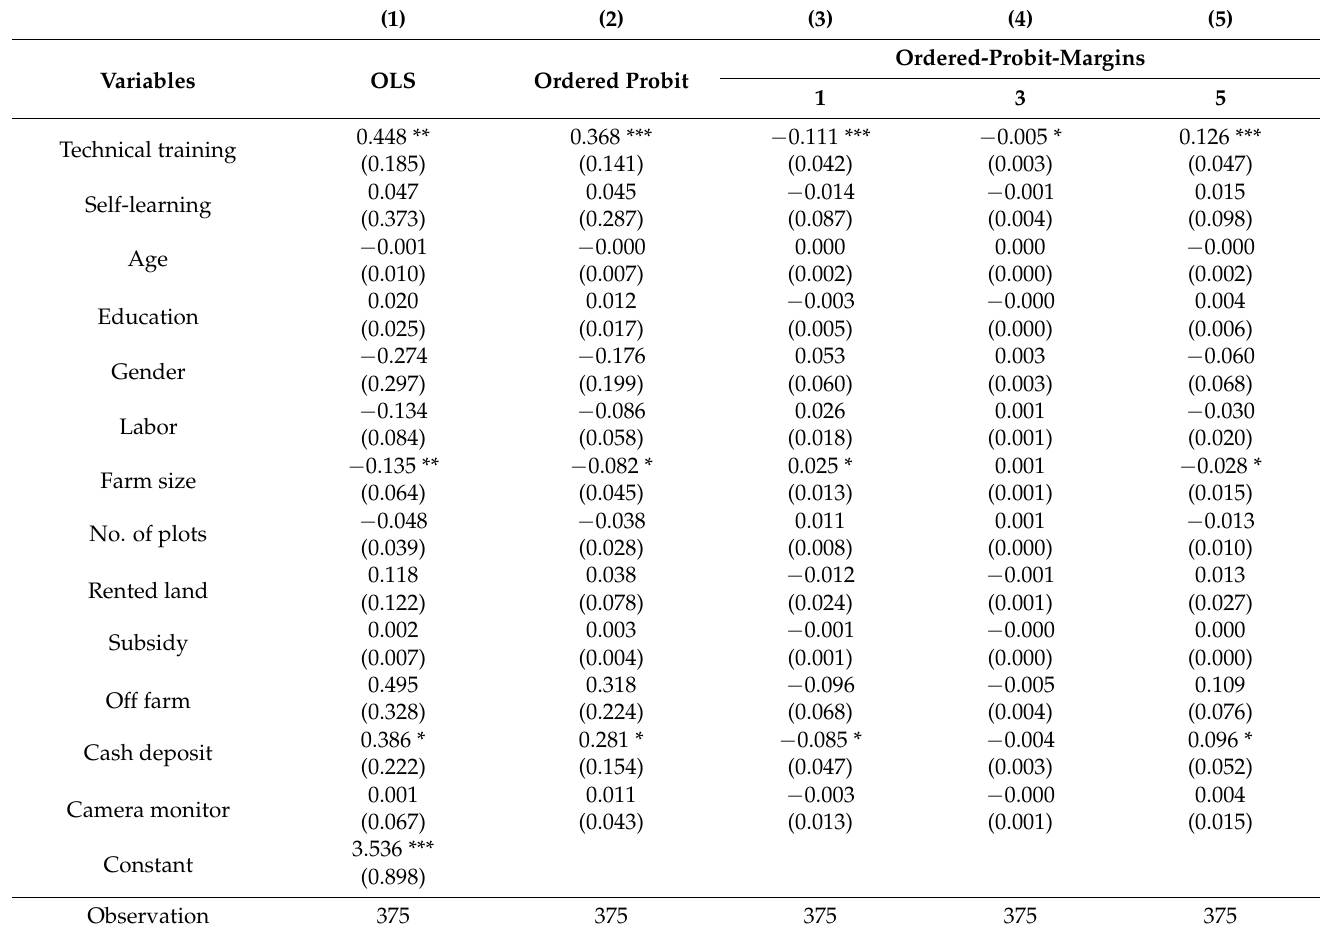
Table 3. Baseline regression